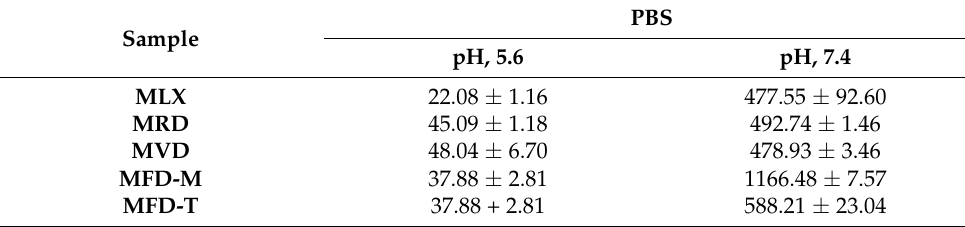
Table 4. Solubility ( µ g mL − 1 ) of MLX and the prepared samples at PBS, pH 5.6 and 7.4 at 25 ◦